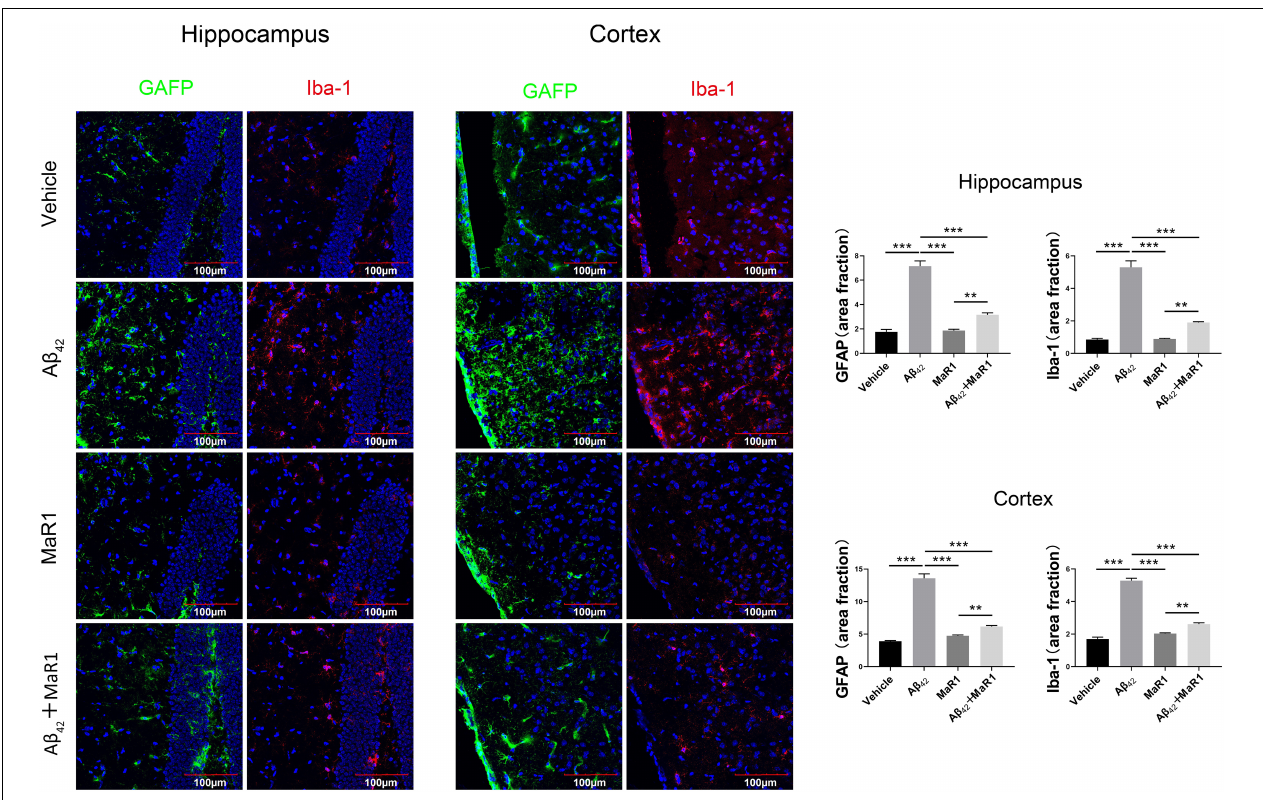
FIGURE 3 | Immunohistochemical staining for microglia and astrocytes in the hippocampus and cortex of AD mouse model. Micrographs and quantification of Iba-1and GFAP positive cells in hippocampus and cortex of the four groups (bar = 100 µ m). The percentage of Iba-1 and GFAP positive in A β 42 group was higher than that in Vehicle group, and these changes were attenuated by A β 42 + MaR1 treatment ( P < 0.001). Data are expressed by mean ± SEM, 10 mice in each group, and statistical significance is defined as follows: ∗∗ P < 0.01, ∗∗∗ P <